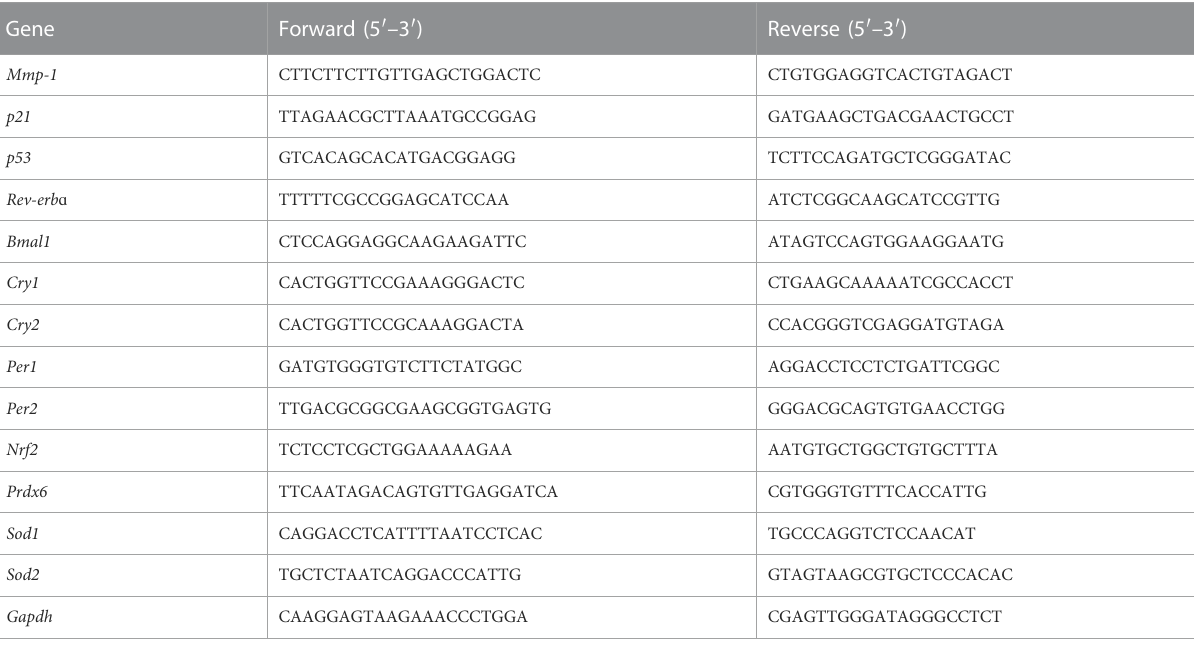
TABLE 1 Primer sequences used for qPCR assays.